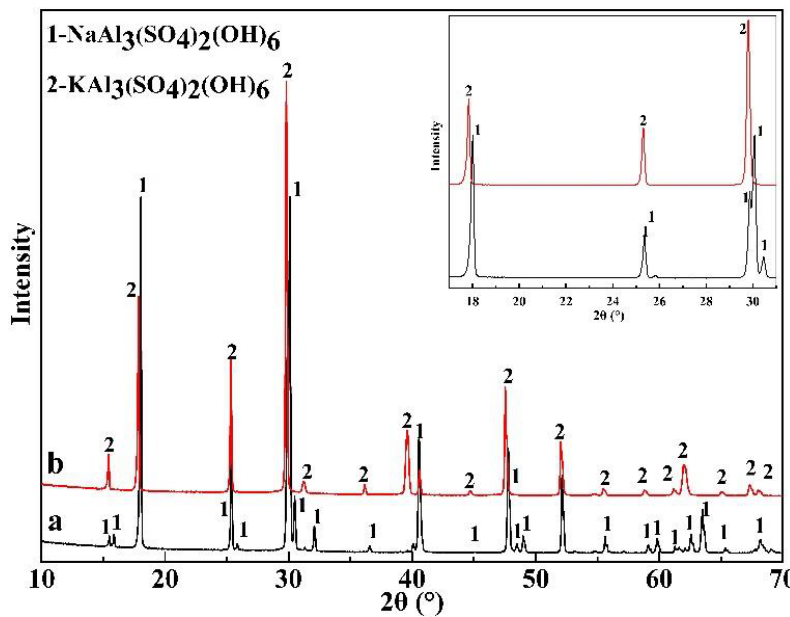
Figure 2. XRD patterns of precipitate obtained at pH value of 0.4: ( a ) Na 2 SO 4 ; ( b ) K 2 SO 4 .